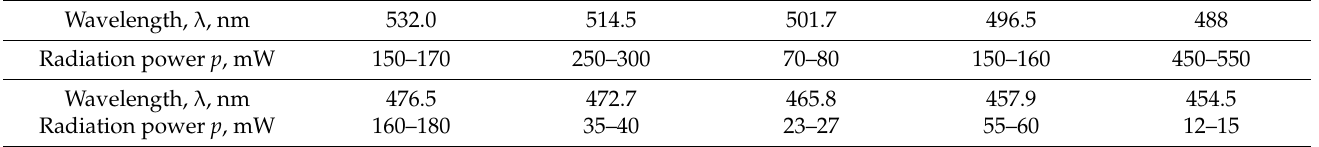
Table A1. Radiation power of solid-state DPSS (532.0 nm) and Ar + (all other wavelengths) lasers used as a source of monochromatic radiation in the laser photometry